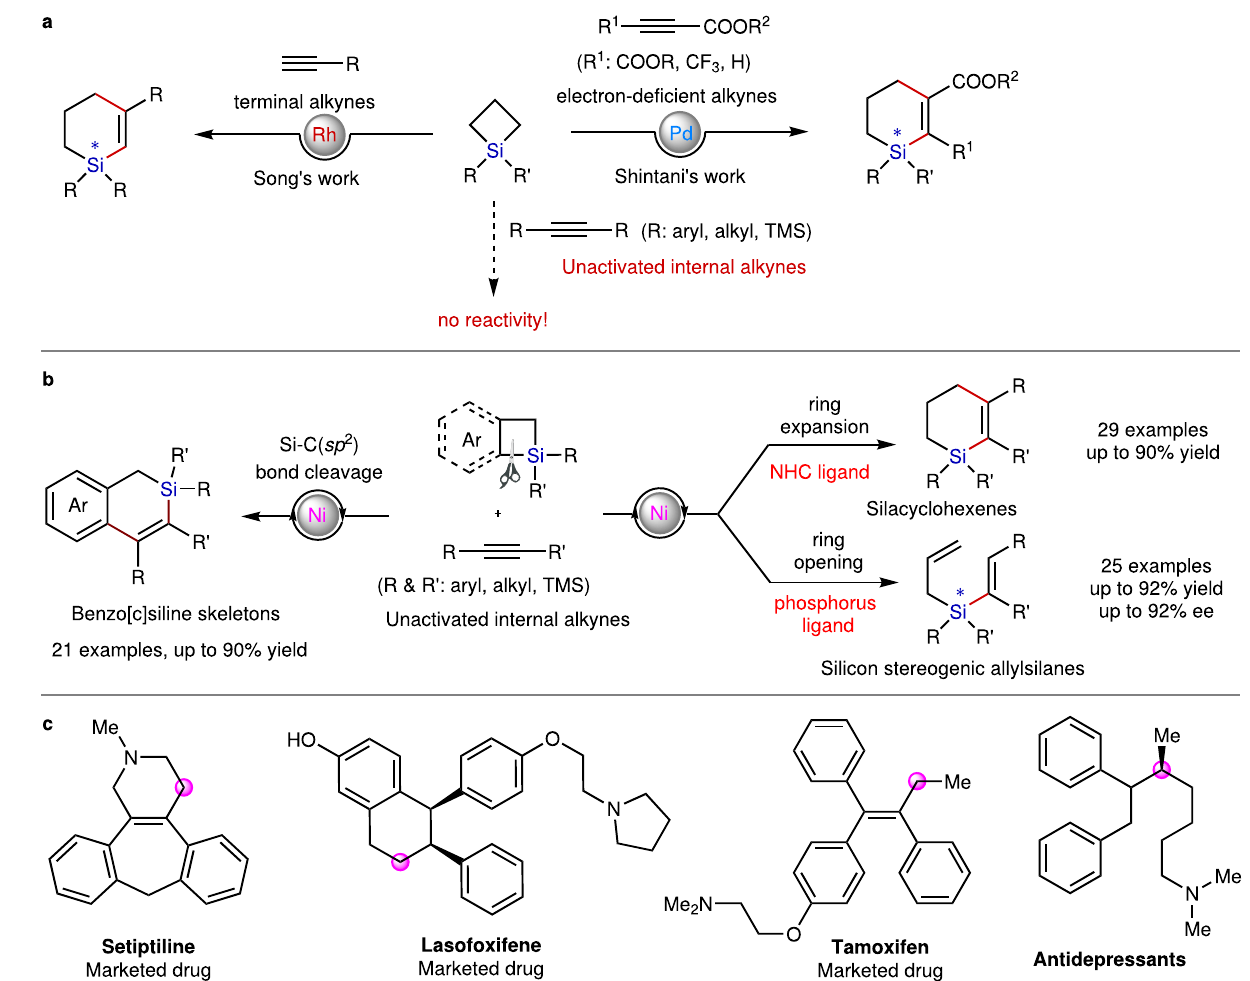
Fig. 1 Research background and our work on the reaction of SCBs and benzosilacyclobutenes with alkynes. a Pd or Rh-catalyzed reaction of SCBs with alkynes in literature. b This work for Ni-catalyzed divergent reactions of SCBs with alkynes. c Medicinally relevant molecules possessing vicinal-diaryl structures. The potential “ C/Si switch ” site in those vicinal-diaryl structures has been highlighted by pink